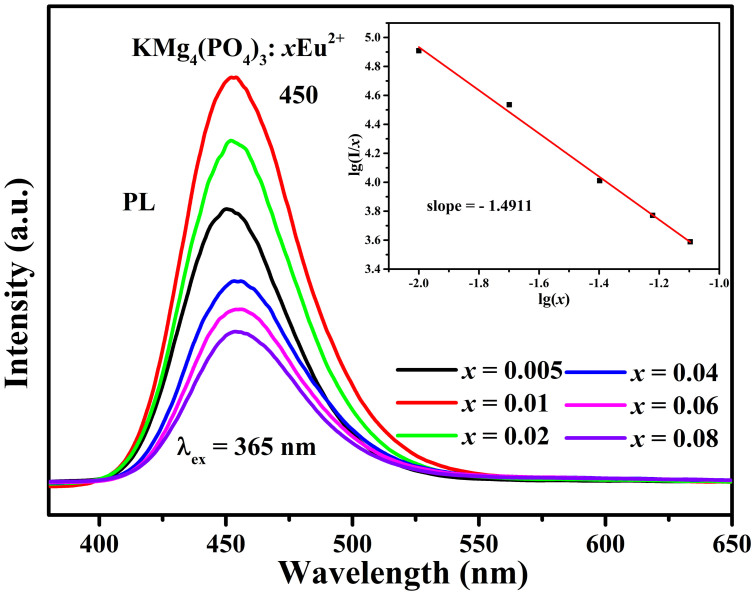
PL spectra for KMg4(PO4)3:xEu2+ (x = 0.005–0.08) phosphors.The inset shows the fitting line of lg(I/x) versus lg(x) in KMg4(PO4)3:xEu2+ (x = 0.005–0.08) phosphors beyond the quenching concentration.